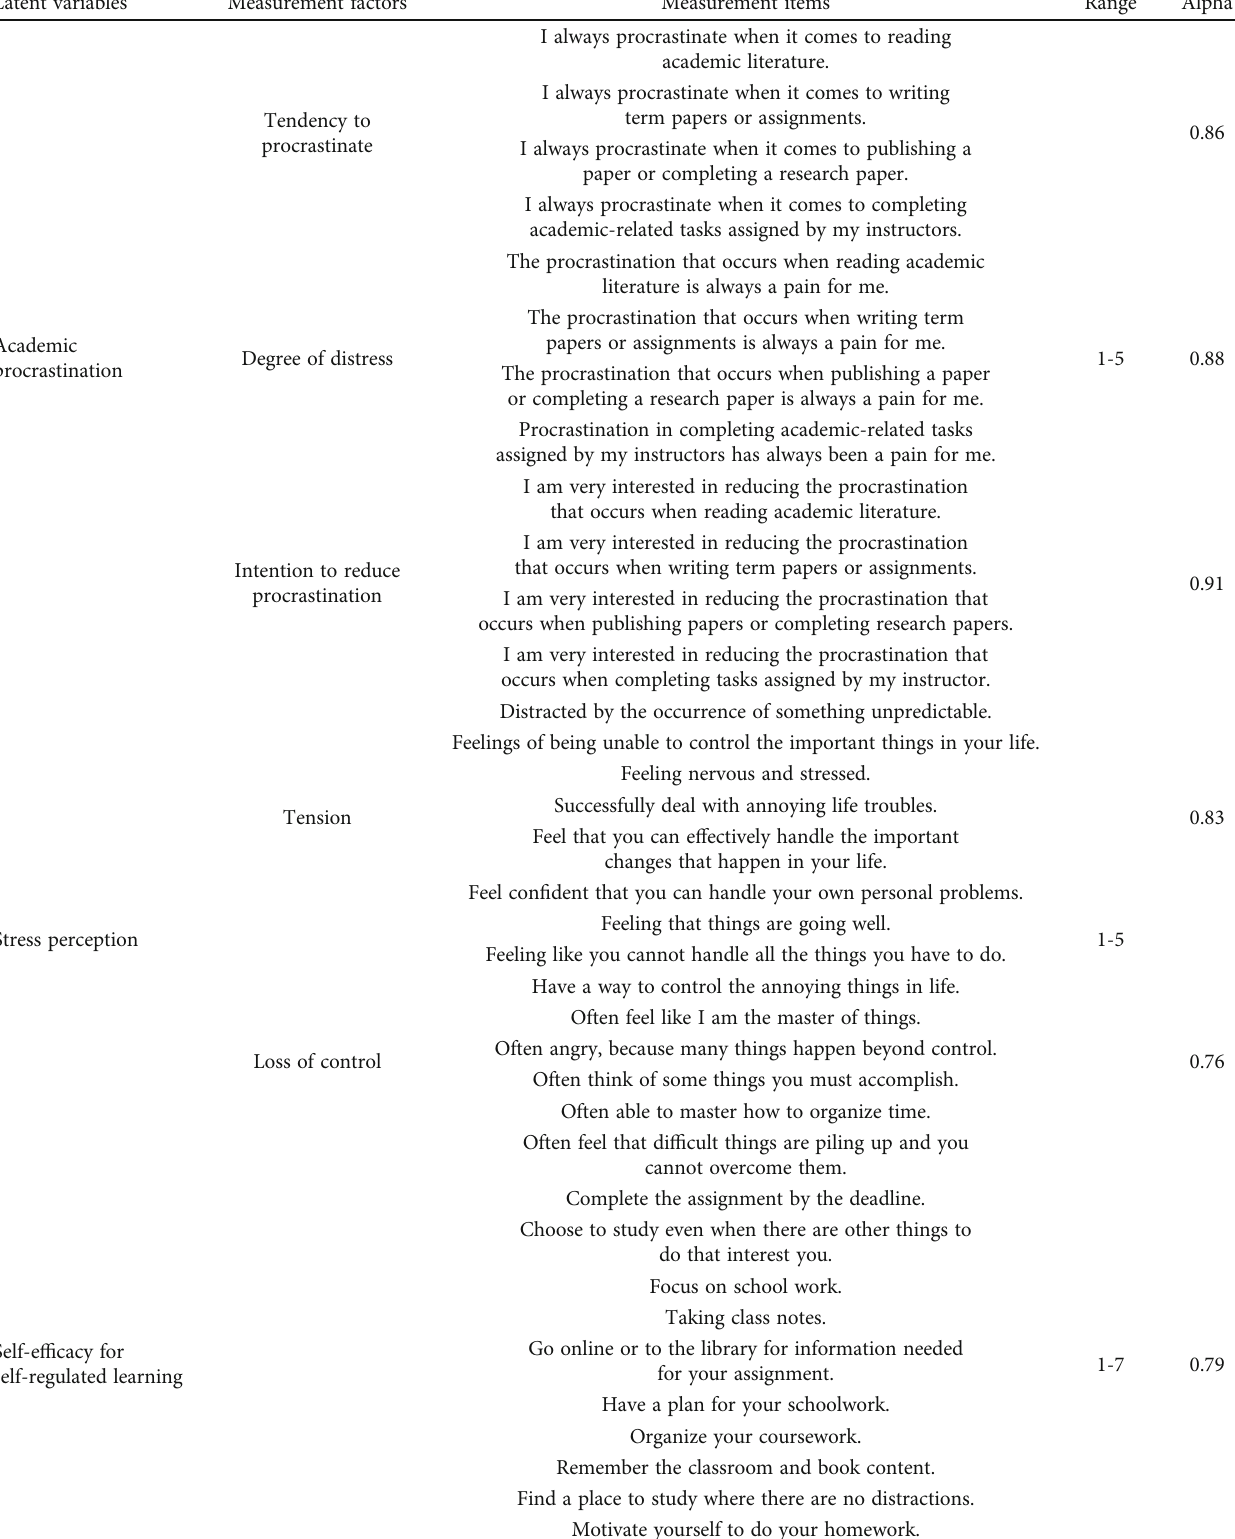
Table 1: Questionnaire